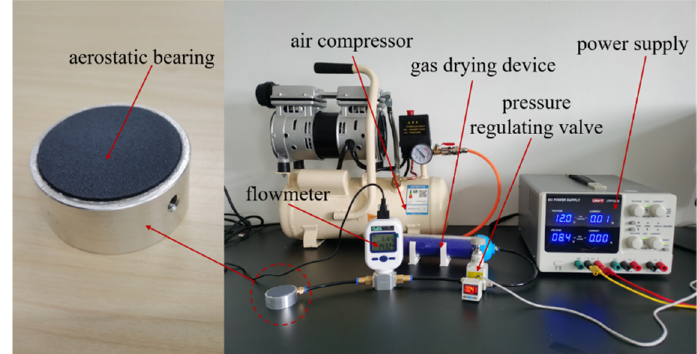
Figure 3. Permeability-coefficient measuring device system. Table 1. The flow measurement data of porous SiC ceramic.